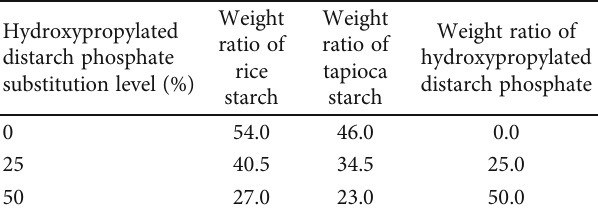
Table 1: Composition of starch blends used in this study. Hydroxypropylated distarch